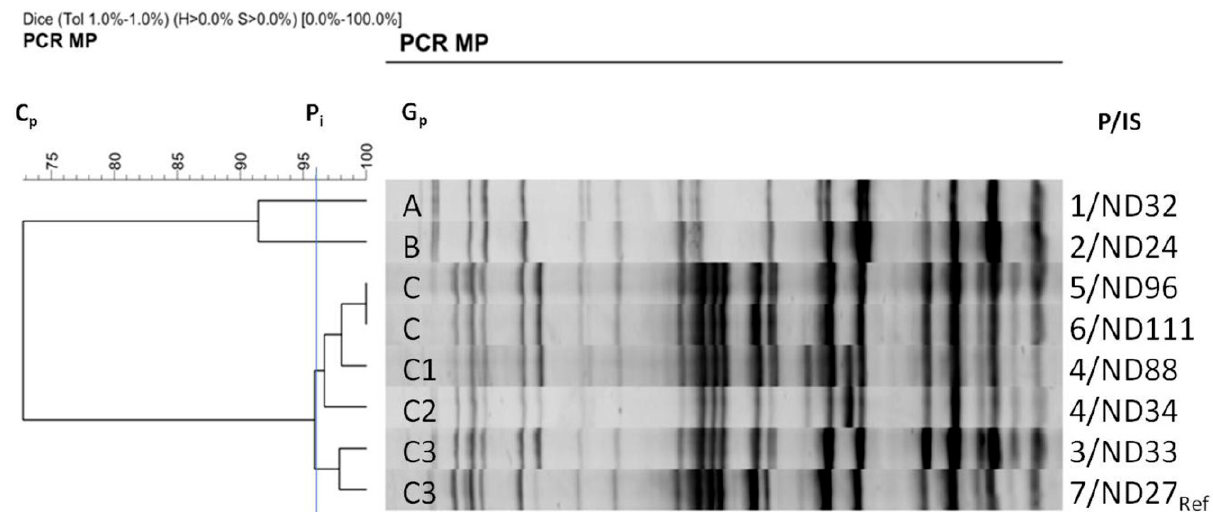
Figure 1. Genetic relatedness of 7 K. pneumoniae NDM-1 strains isolated from six patients and a reference K. pneumoniae NDM-1 strain (from another hospital used as a control) based on the PCR MP method. A dendrogram of similarity of the genetic profiles of the tested strains was developed using FPQuest Software version 4.5 (BIO-RAD) (Dice, UPGMA). Cp—the complete similarity equal to 73%; Pi—the level of identity equal to 96%; unique genotypes (Gp) are marked with the letters A – C ; IS—isolate; P—patient.